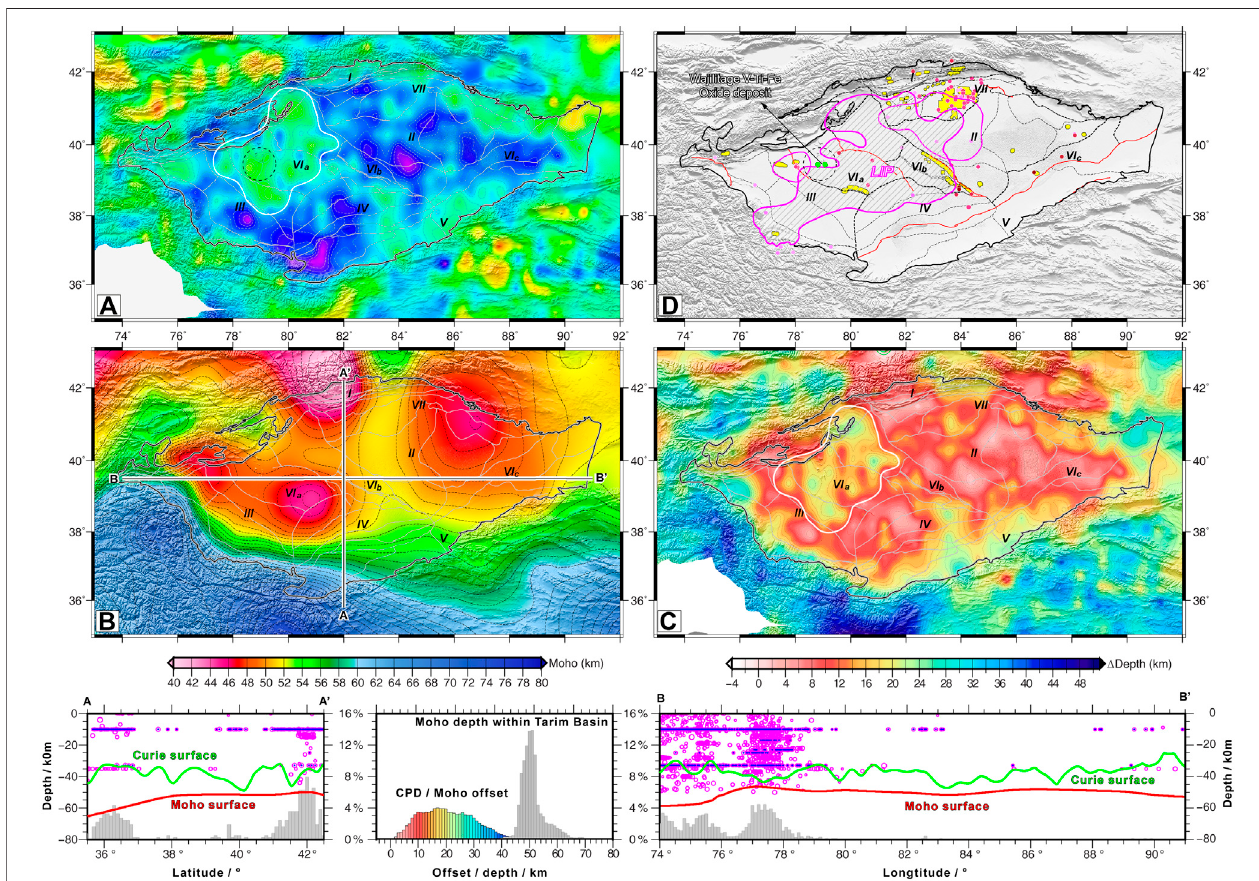
FIGURE 9 | (A) Spatial variations in the CPD map in the digital elevation model. (B) Moho map (crustal thickness, CT), compiled from the datasets from Teng et al. (2014).ThedistributionofMohodepthvalueswithintheTarimBasinareplottedbelowthecorrespondingMohoillustration.TransectsAA ’ andBB ’ crosstheTarimBasin longitudinallyandlatitudinally,respectively.Inthesections,thepurplecirclesareearthquakesoriginatedfromISC(http://www.isc.ac.uk/),thethicksolidredcurveshows the Curie depth, and thick green curve is the Moho depth. The purple circles are earthquakes with focal depths after relocation. In contrast, the blue circles are earthquakes with focal depths of non-relocation. The probability plots of earthquakes in the Tarim Basin and its environs are exhibited in the sections. (C) Curie-Moho Depth offset, with the distribution of these offsets illustrated below. (D) The tectonic and oil-and-gas- fi eld maps. The legends are same as in Figure 1B . The solid, thick white curve in Panel A,C presents the regions marked by minimum values. The black dotted circle denotes the low-CPD path, corresponding to the Wajilitage V-Ti-Fe oxide